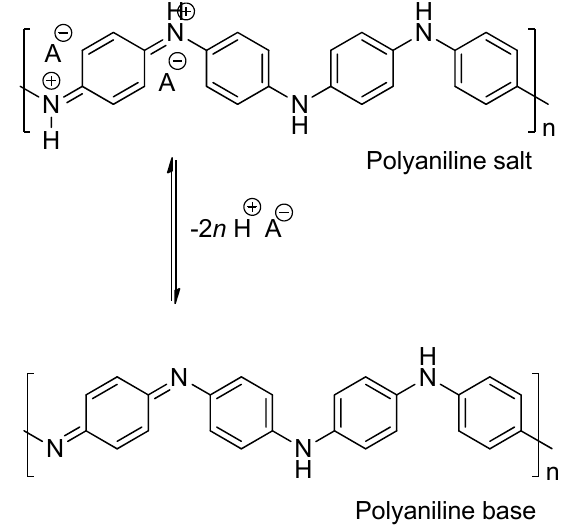
Figure 1. Chemical structure of polyaniline emeraldin salt (PANI-ES) and polyanaline emeraldin base (PANI-EB).